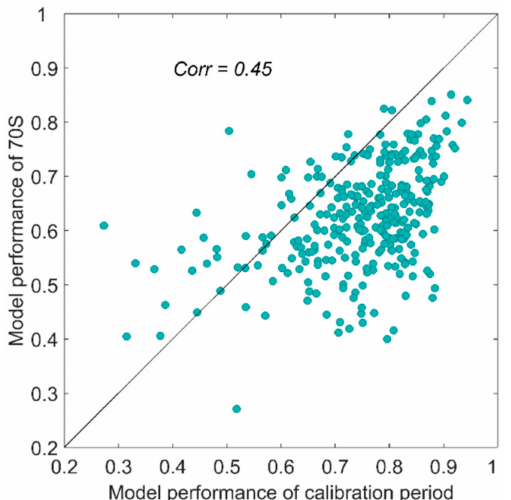
Figure 2. Comparison of Nash–Sutcli ff e and Bias ( NSB ) for the one-year data based calibration and for the validation of period